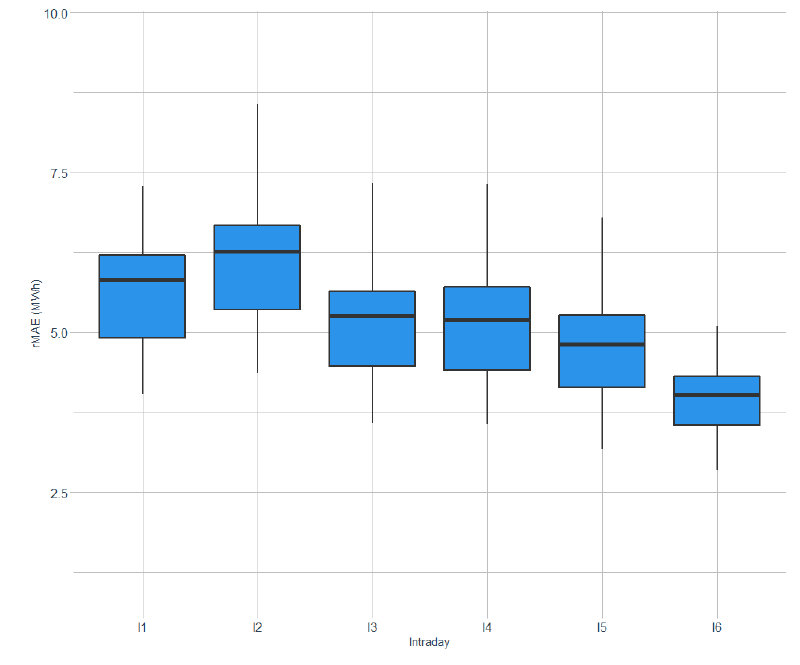
Figure 6. RMAE distribution by intraday